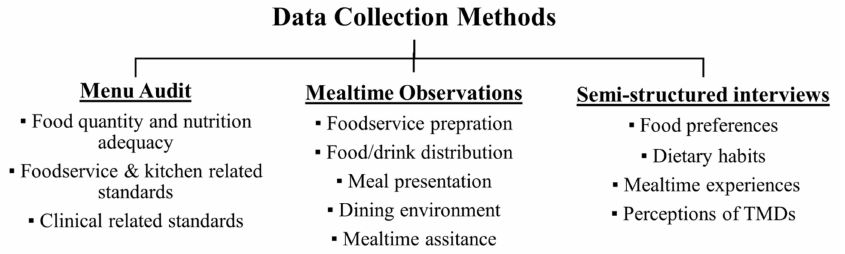
Figure 1. The data collection methods used in the study and the information collected from each method. TMDs = Texture-Modified